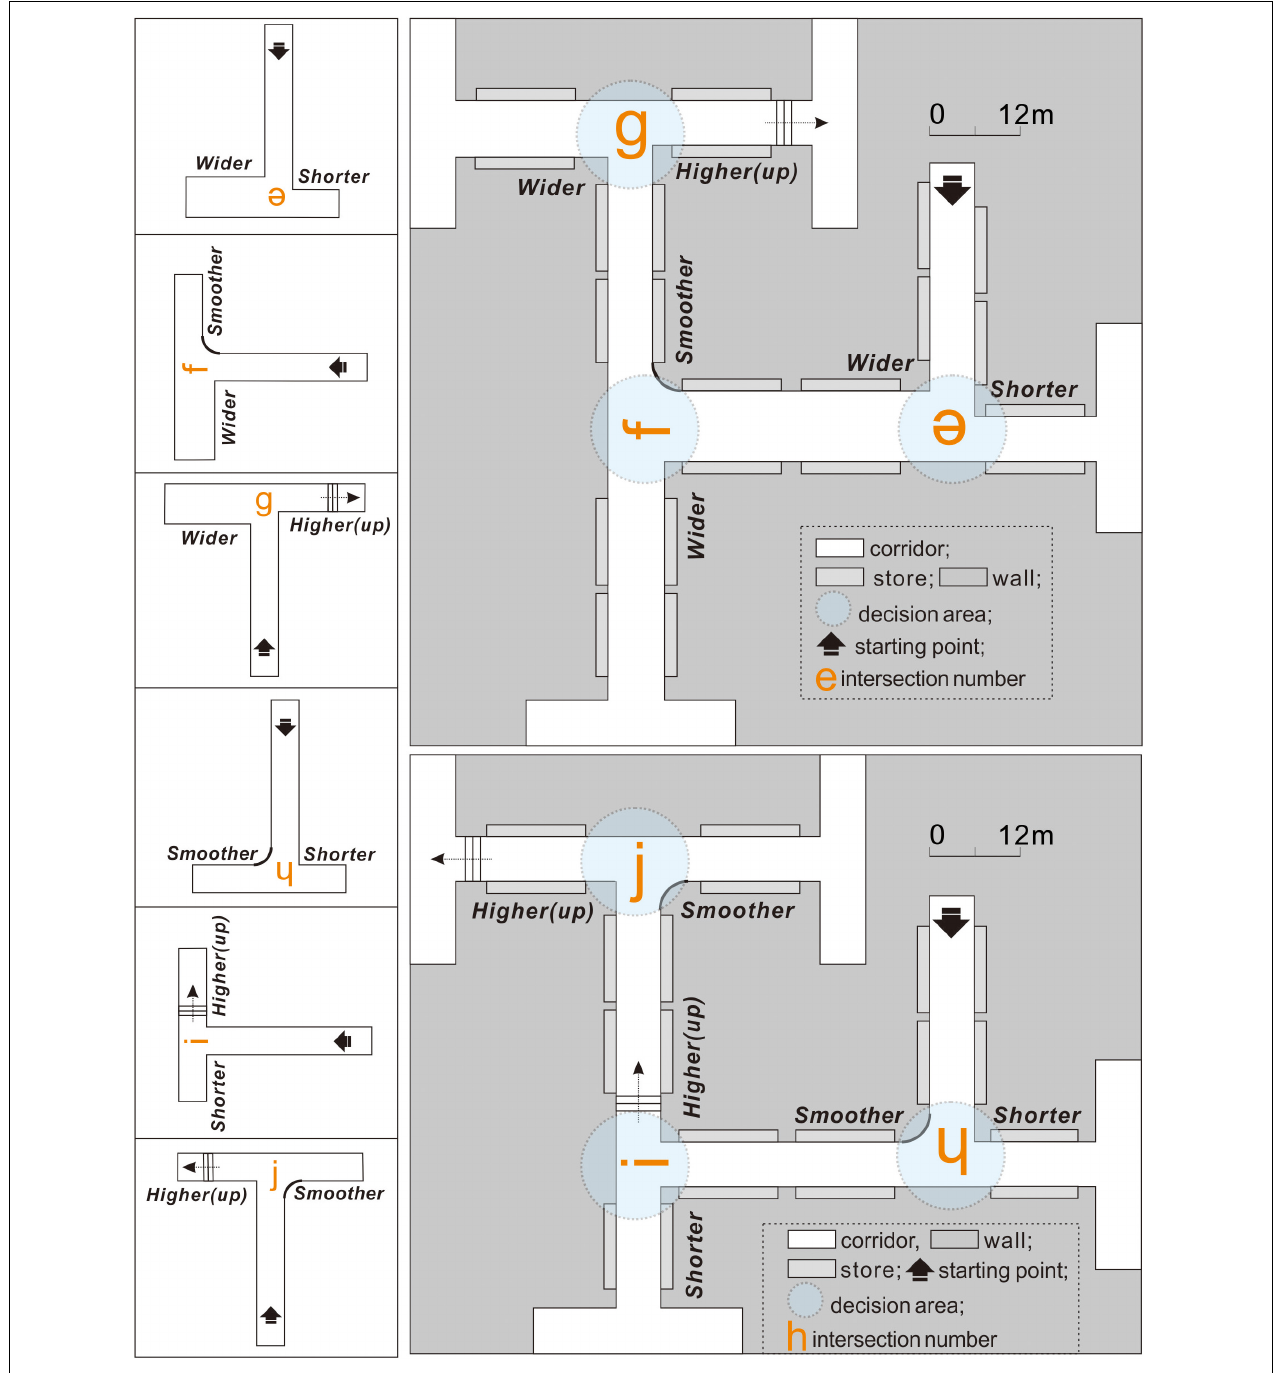
FIGURE 6 | In experiment 3, intersections e – j have different corridor configuration attributes on both sides at intersection t .